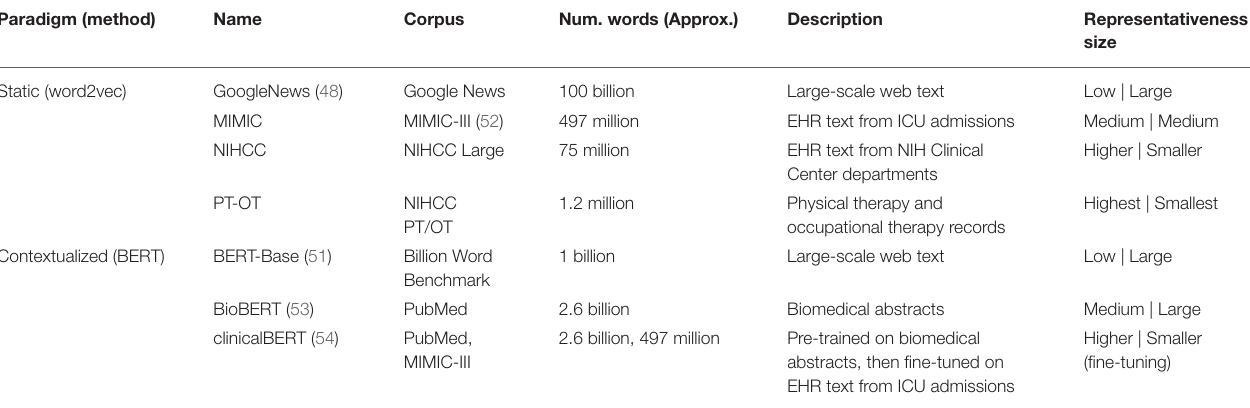
TABLE 2 | Text corpora used to pre-train embedding models for use in ICF coding experiments. Paradigm